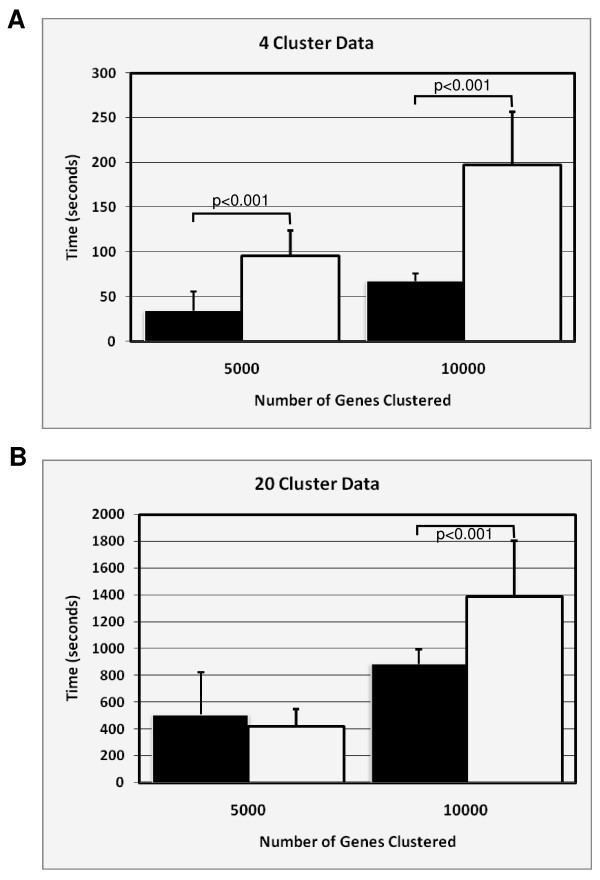
Time comparison of Cluster and ParaKMeans. ParaKMeans was run using single node/RIA configuration. The calculated p values are presented above the comparisons. A) 4 cluster data B) 20 cluster data. White bars = Cluster; black bars = PKM.